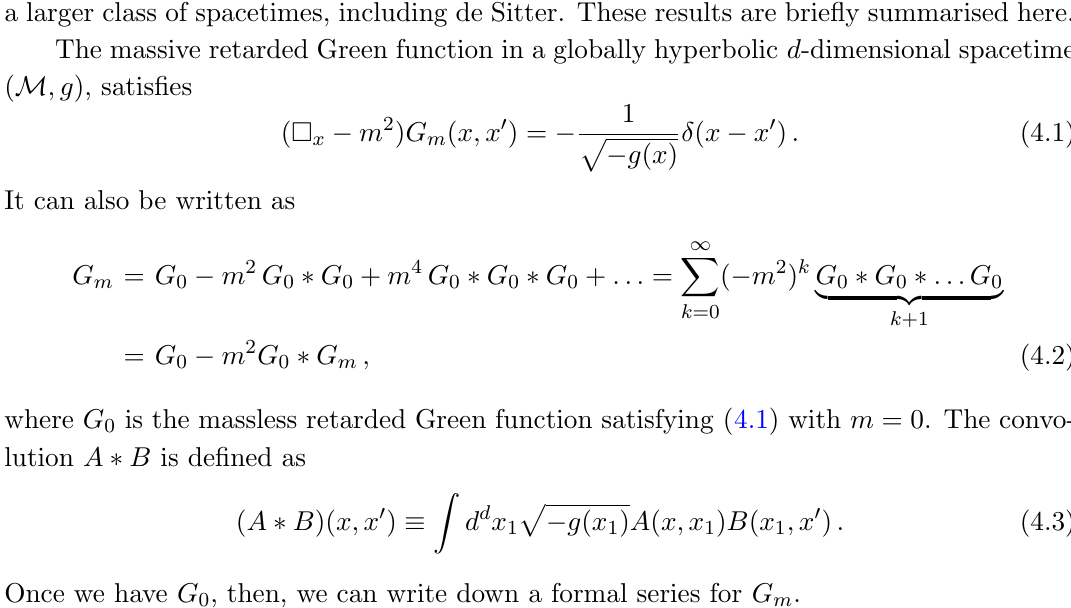
1 . 4 < ˜ T < 1 . 4, (cid:27) = −